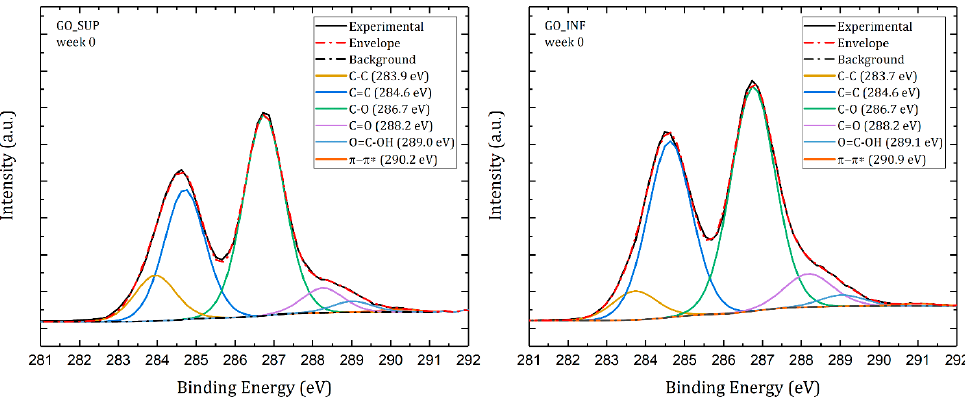
Figure 10. Deconvoluted C1s core-level XPS spectra of the dried GO_SUP ( left ) and GO_INF ( right ) samples obtained immediately after synthesis.